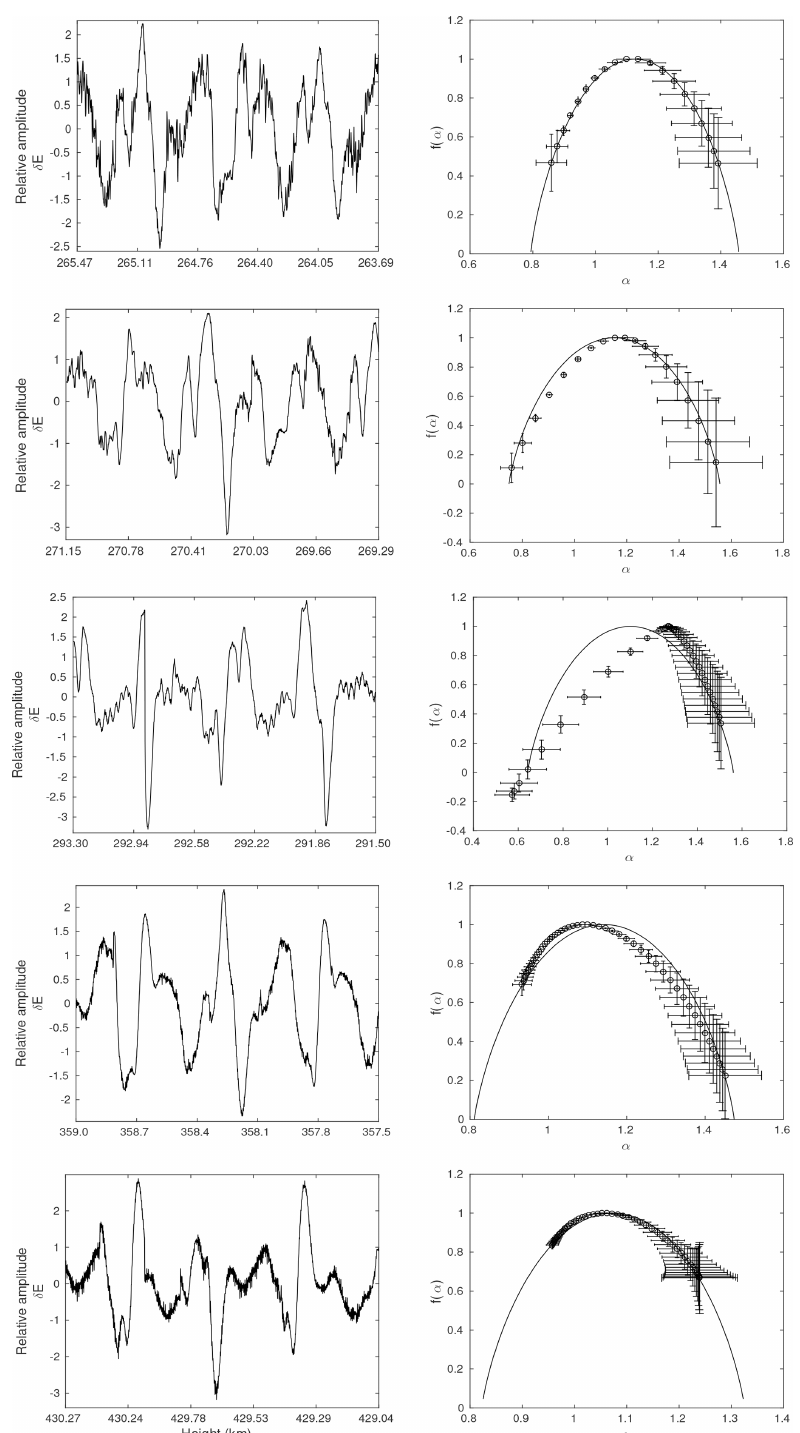
Figure 3. MFDFA for the first experiment: the time series and its corresponding multifractal spectrum with the p -model fit (continuous line) for the mean heights of 264.58, 270.22, 292.37, 358.56, and 429.65km, from top to bottom,